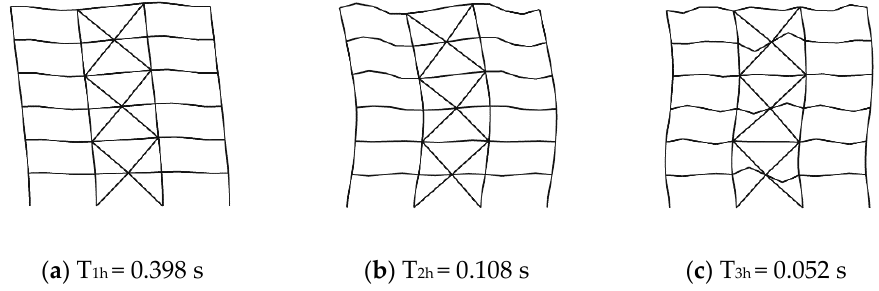
Figure 2. Horizontal vibration modes for the six-story building.